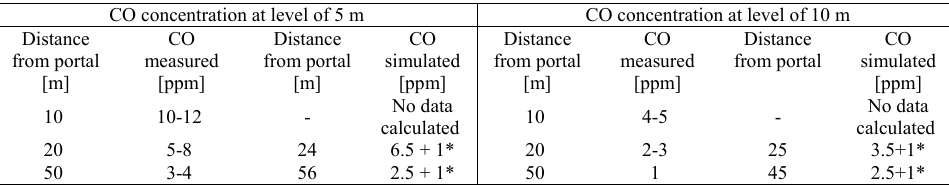
Table 2: CO concentration around the southern tunnel portal–one h. average measurement